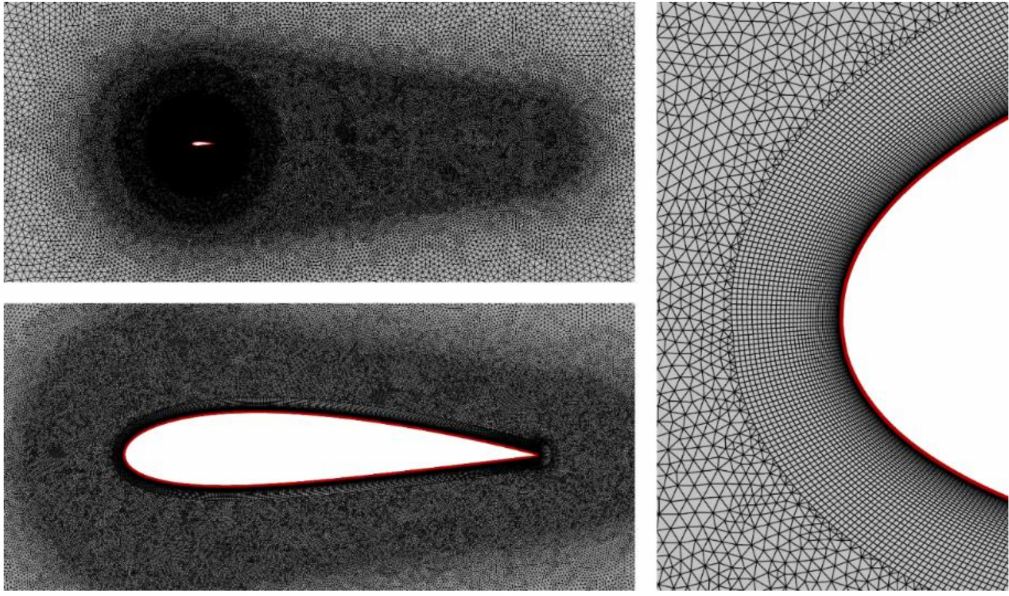
Figure 8. Computational grid used for the airfoil polars